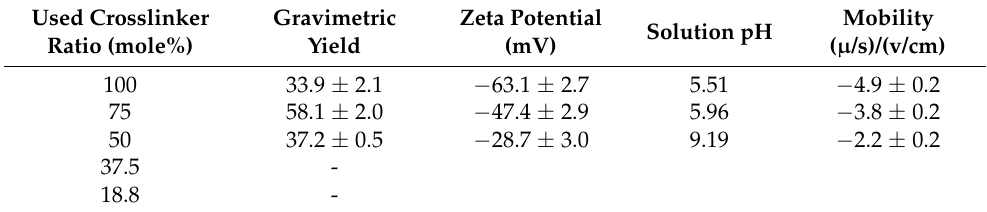
Table 1. Gravimetric yields, zeta potentials, pH and mobility of p(Gly) particles. Used Crosslinker Ratio